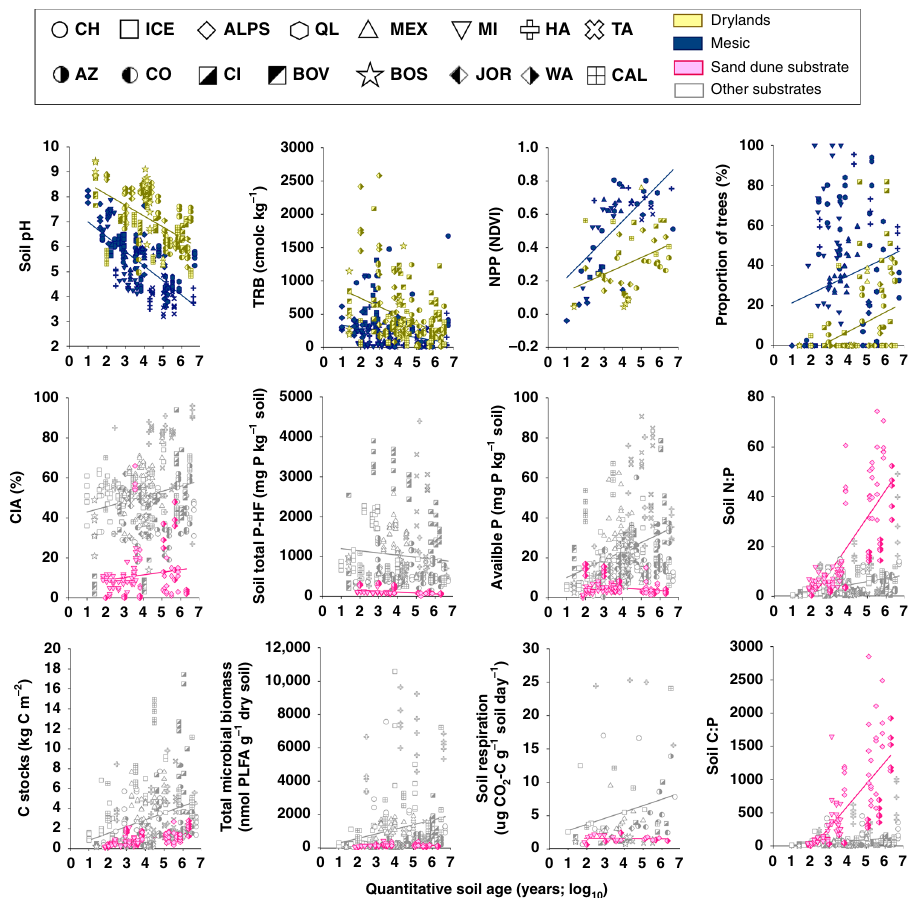
Fig. 5 Environmental context determines the rates and trajectories of ecosystem development. Selected relationships between quantitative soil age and ecosystem properties across major biome categories (drylands vs. mesic) and substrate types. See Supplementary Table 6 for statistical